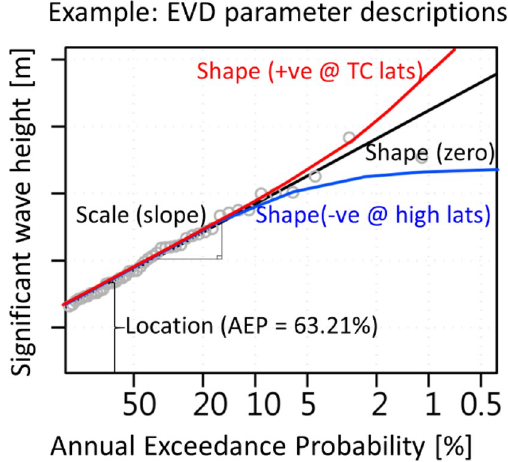
Figure 1. Idealised return level diagram describing the EVD location, scale and shape parameters. Red curve is for a GEV distribution with a positive (+ve) shape parameter typically found at TC latitudes, the black curve is for a Gumbel distribution (zero shape parameter) and the blue curve is for a GEV distribution with a negative (− ve) shape parameter typically found at high latitudes. Grey circles represent pseudo empirically-ranked annual maximum Annual Exceedance Probability (AEP). Created using the R statistical software version 4.0.2 22